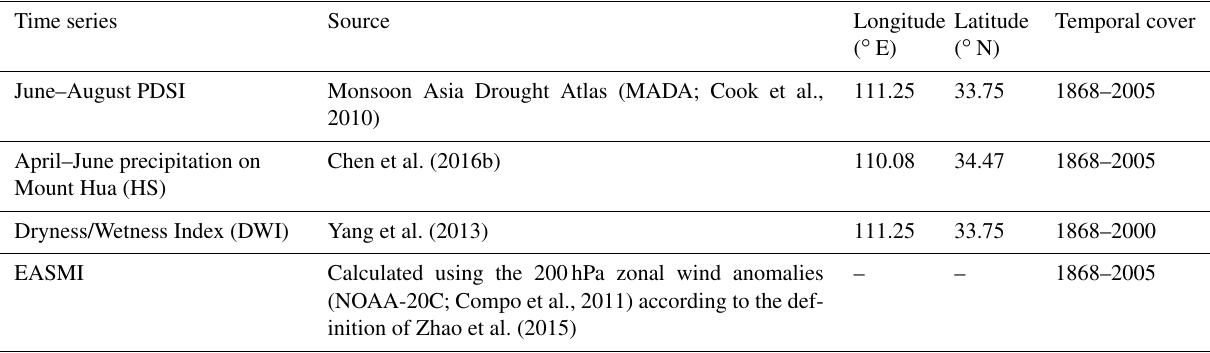
Table 2. Long-term hydroclimatic reconstructions and East Asian summer monsoon index (EASMI) selected for comparing with the recon- structed MJJ scPDSI from this